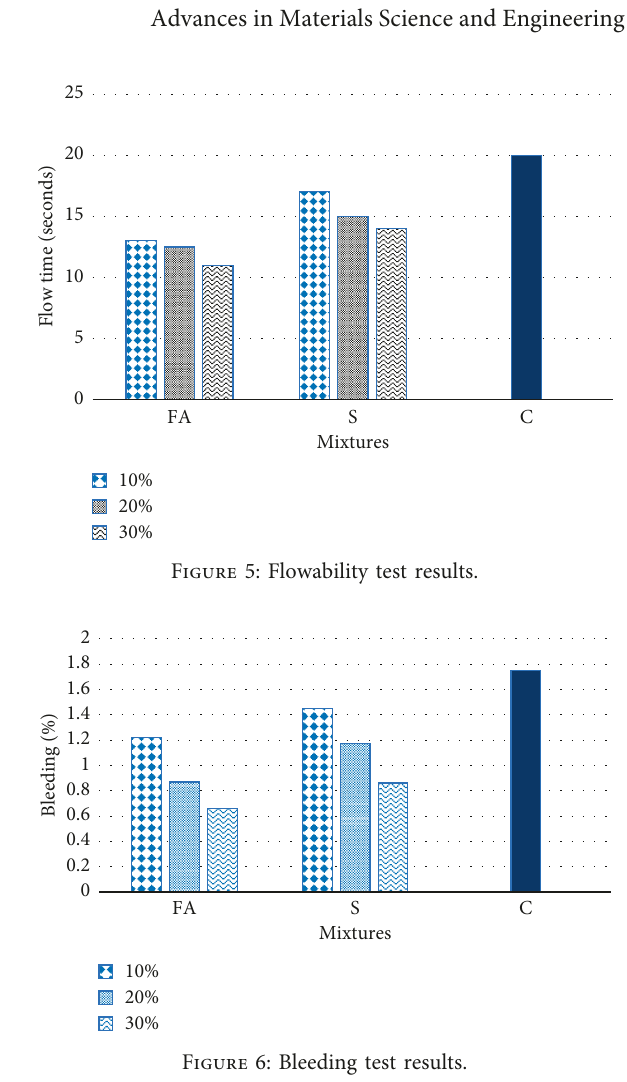
Figure 6: Bleeding test